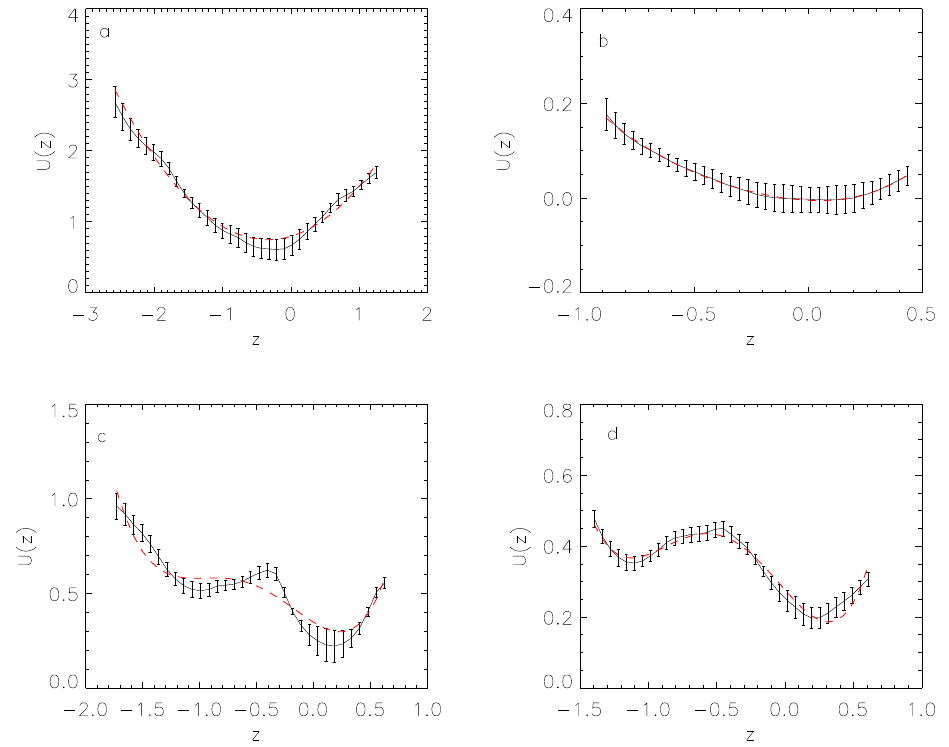
Figure 6. Potentials U(z) calculated from the data (black curves and error bars) using Eq. (11) and polynomial best fits (red dashed curves) for NGRIP reconstructions N H (t) (a) , N L (t) (c) , and EDML reconstructions S H (t) (b) , S L (t) (d). errors on the age scale available in the EDML and NGRIP 385 data were used in a Montecarlo algorithm to estimate the time errors on N L ( t ) and S L ( t ) . More specifically, we calculated 10 3 realizations of the long time-scale reconstructions vary-